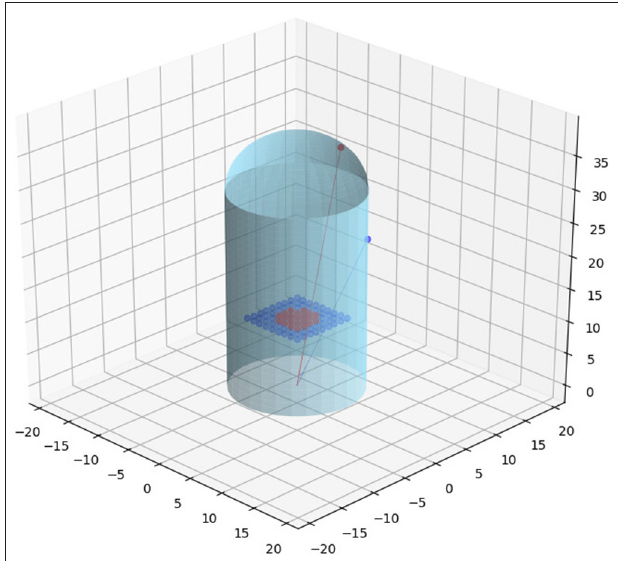
FIGURE 3 | Two projection rays that correspond to the spherical (in red) and cylindrical (in navy blue) regions are depicted in the figure. Each ray intersects three relevant points: the frame of reference origin, a point in the sensor surface, and the corresponding projected point in the image plane.